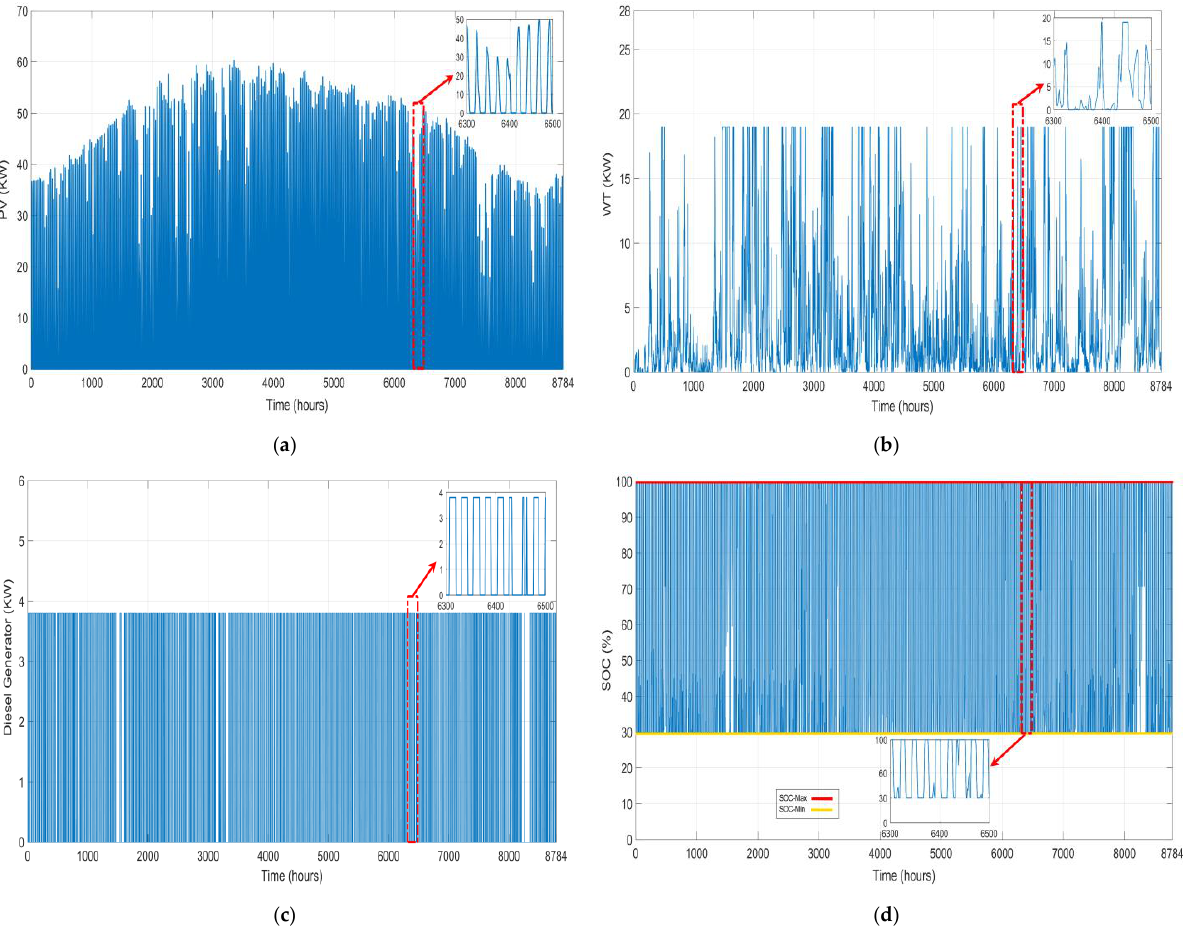
Figure 18. Power generated by the various components of the HMS over one year for MOSSA solution #1. ( a ) PV array; ( b ) WT; ( c ) DG. The annual profile of the battery SOC ( d ).